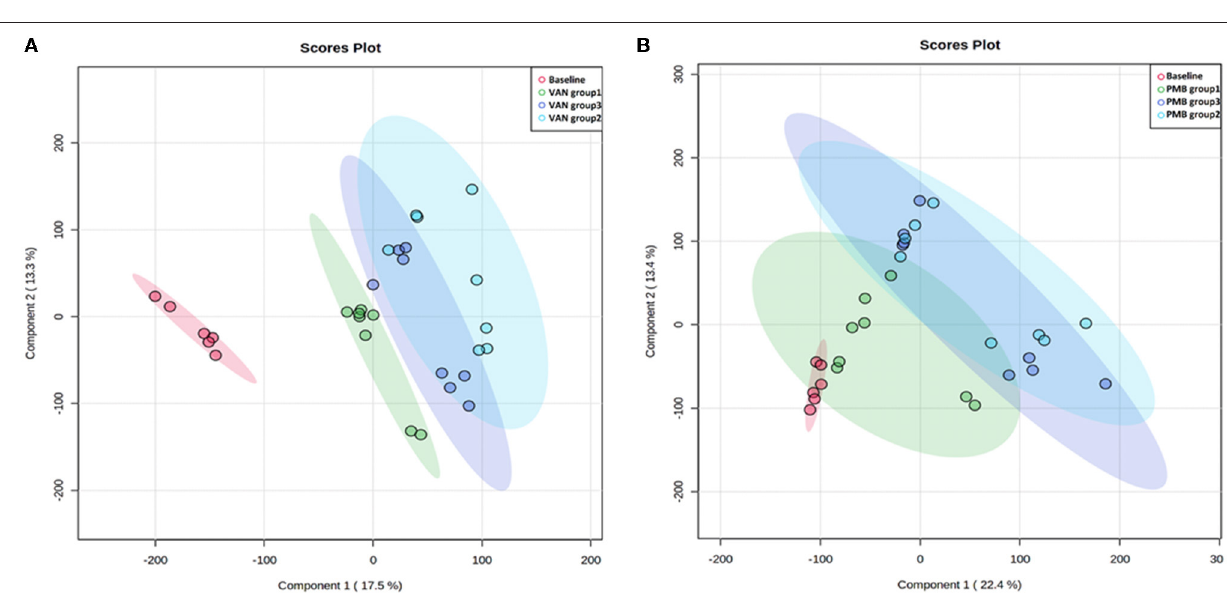
FIGURE 7 | Vancomycin (A) and polymyxin B (B) induced metabolic profiling at different time points determined by partial least squares discriminate analysis (PLS-DA). VAN, vancomycin; PMB, polymyxin B; CON, control. metabolites involved in metabolic pathways are summarized in 0.05). The decreased secondary BAs included deoxycholic acid Supplementary Table 1 and Supplementary Figure 3 . PMB 3- (DCA), tauroursodeoxycholic acid (TUDCA), taurolithocholic week treatment induced only primary BAs changed, a decrease acid (TLCA), isolithocholic acid, and hyodeoxycholic acid of taurine (FC = 0.48, p = 0.04) and TCA (FC = 0.40, p (HCA) (all p < 0.05). The VAN-induced changes in key